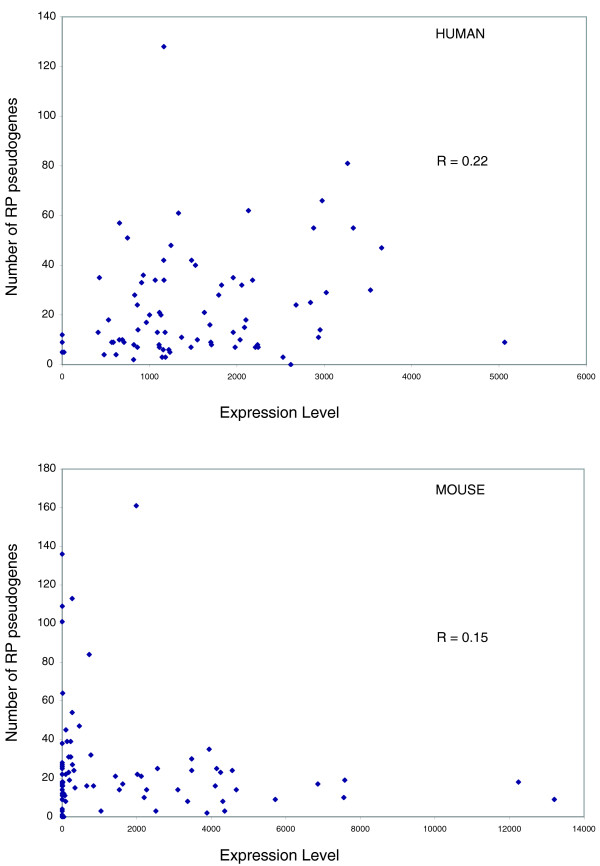
Plot of expression level of mRNA in testes associated with each RP protein versus the number of processed pseudogenes associated with it. The top and bottom panels correspond to human and mouse RP pseudogenes, respectively. The x-axis shows signal on the gene chip, which is a measure of the abundance of a mRNA transcript. Data for the human and mouse are not normalized to each other and should not be compared directly. It should be noted that expression data for some RP proteins for mouse are missing in the GEO data.